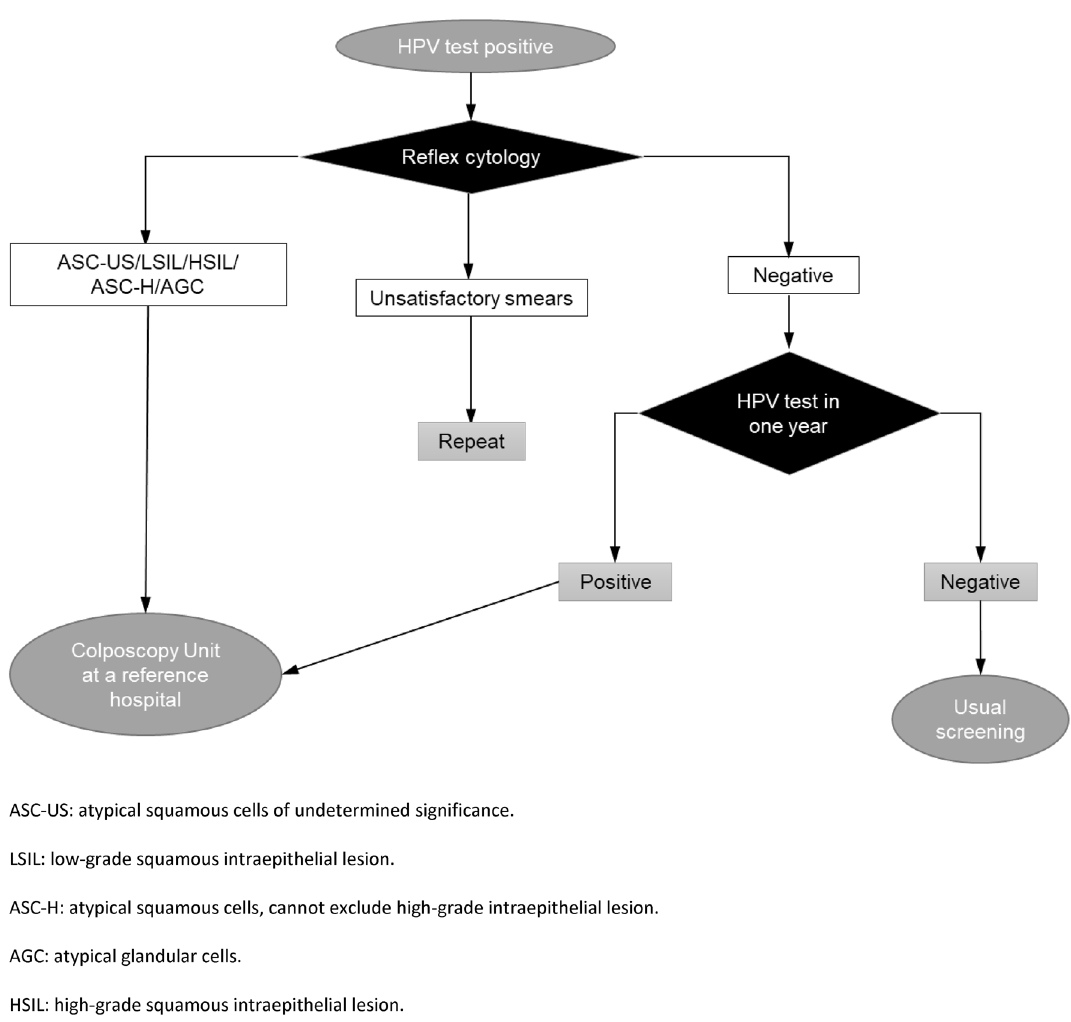
Figure 3. Management algorithm for positive HPV assays in women aged 35–65